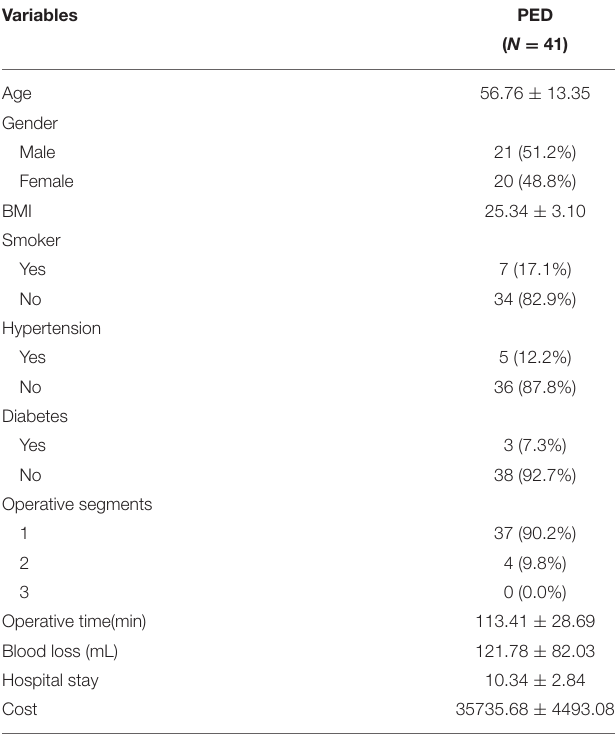
TABLE 1 | Clinical characteristics of included